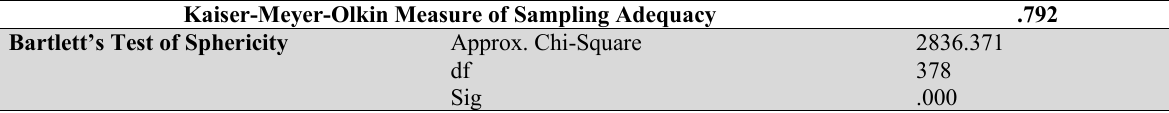
Kaiser-Meyer-Olkin (KMO) sample adequacy